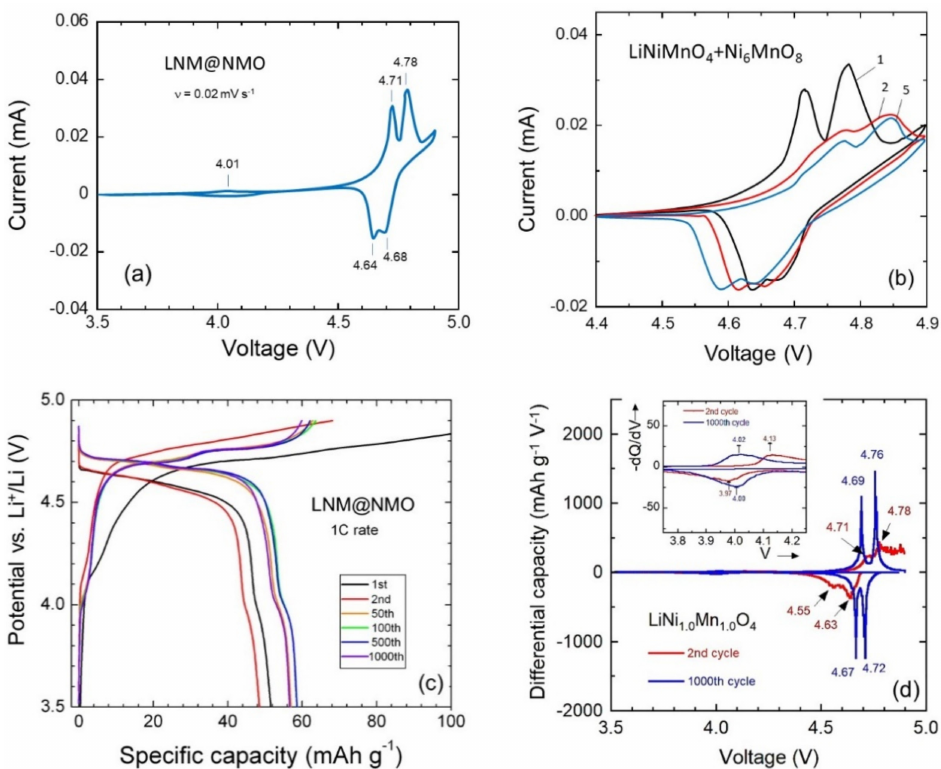
Figure 7. Electrochemical performance of the LiNiMnO 4 @Ni 6 MnO 8 composite electrode. ( a ) Cyclic voltammograms recorded at the slow scan rate 0.02 mV s − 1 in the voltage range 3.5–4.9 V. ( b ) First to fifth detailed CV responses in high voltage region. ( c ) GCD profiles carried out at 1C rate in the voltage between 3.5 and 4.9 V upon 1000 cycles. ( d ) Differential capacity analysis ( − d Q /d V ) vs. voltage for the second and 1000th cycles. Table 4. Values of the CV peaks ( Φ anodic and Φ cathodic in V) and the potential difference ( ∆Φ in